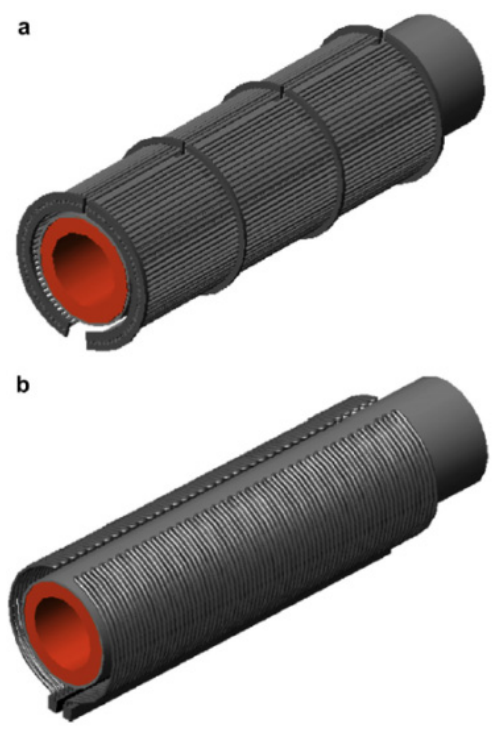
Fig. 2. The heat exchanger : a) in tube arrangement located coaxially on the external layer of the rotary kiln, b) in the arrangement of bent tubes [18].